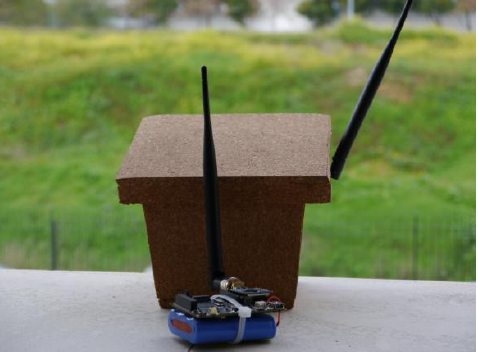
Figure 19. Node of an ICAROn